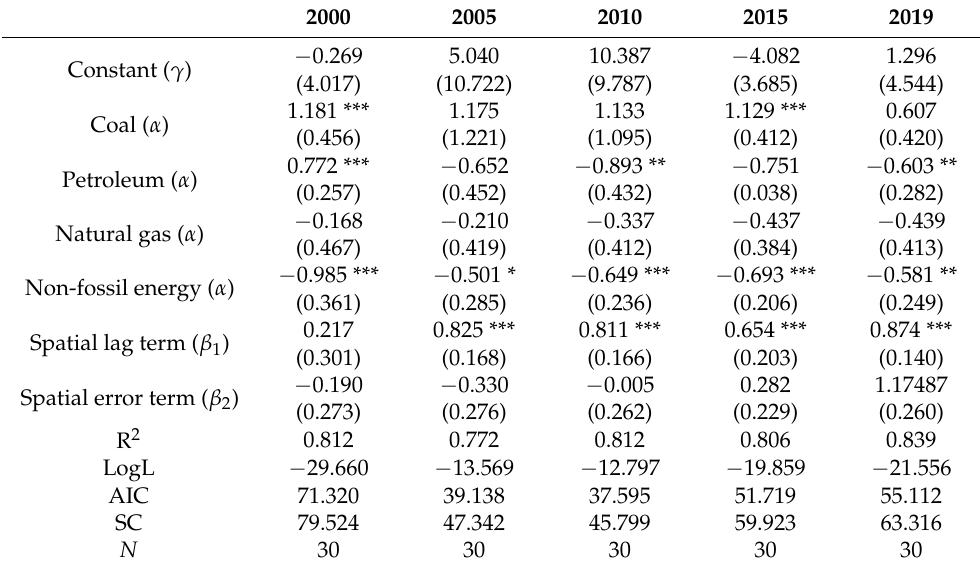
Table 7. Spatial regression results for CO 2 emissions per unit GDP in China (five-time sections), based on the SEMLD